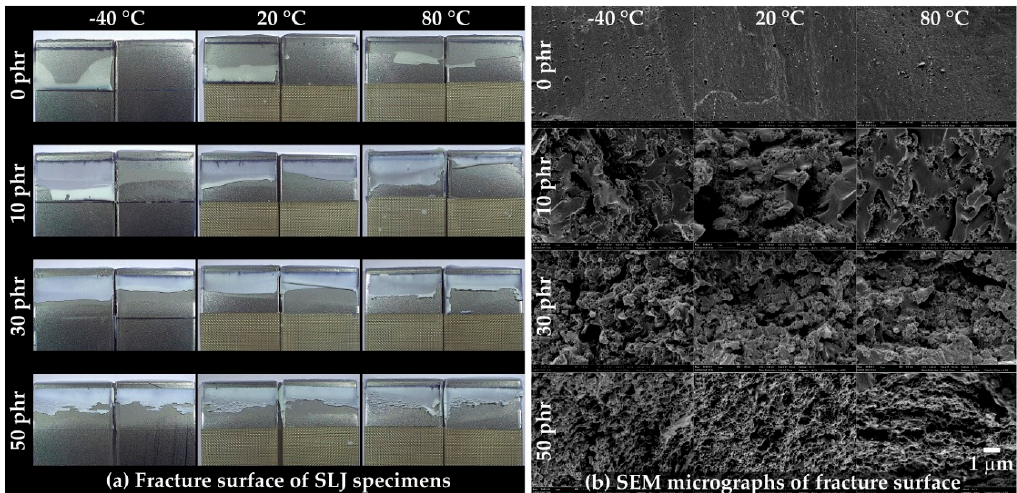
Figure 11. ( a ) Fracture surface of the SLJ specimens captured by optical microscopy (OM) and ( b ) FE-SEM micrographs of the fracture surface.